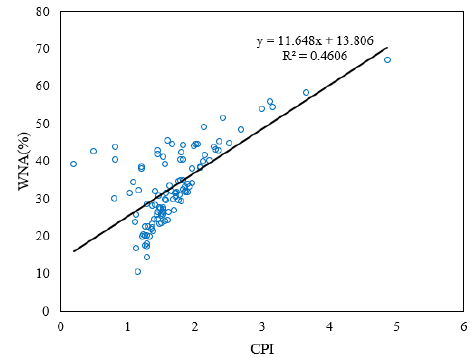
Figure 5. Carbon preference index (CPI) and wax n-alkanes percentage (WNA) correlation Plot. Table 7. Seasonal n-Alkane index.